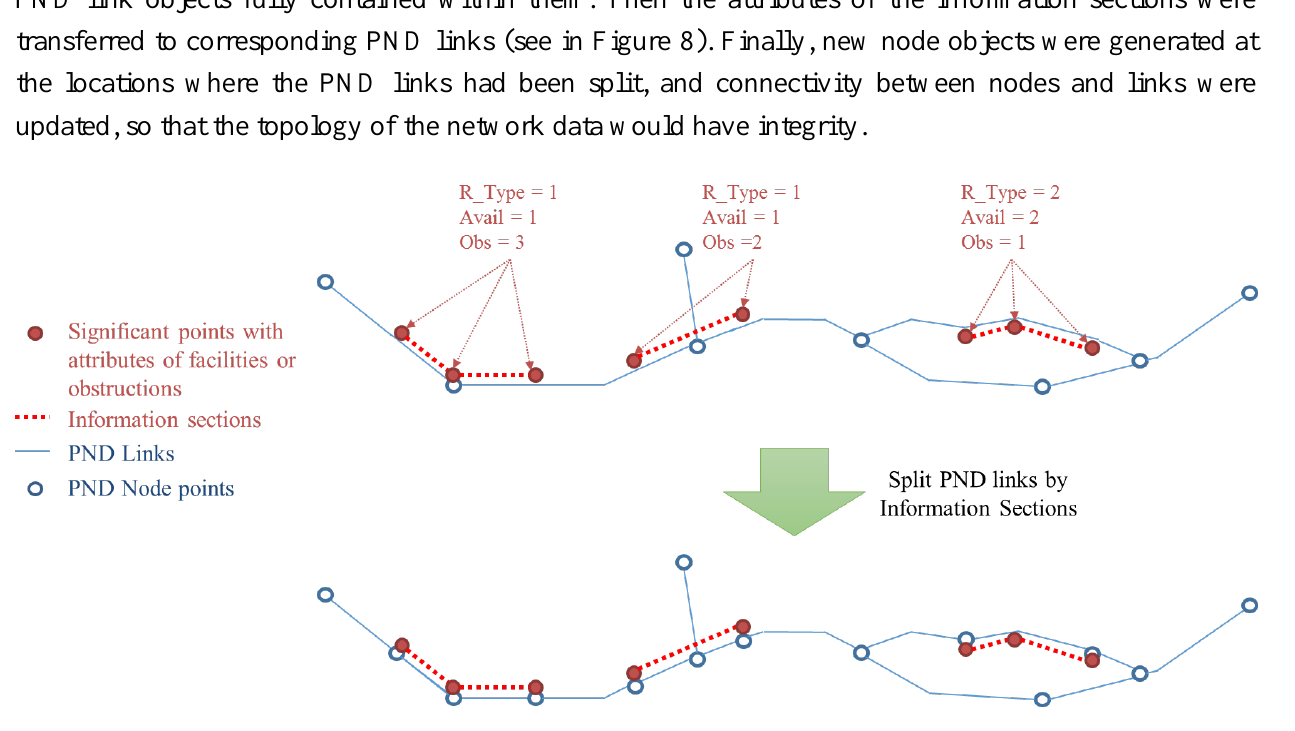
Figure 7. Process for splitting PND link objects at the start or endpoints of the information